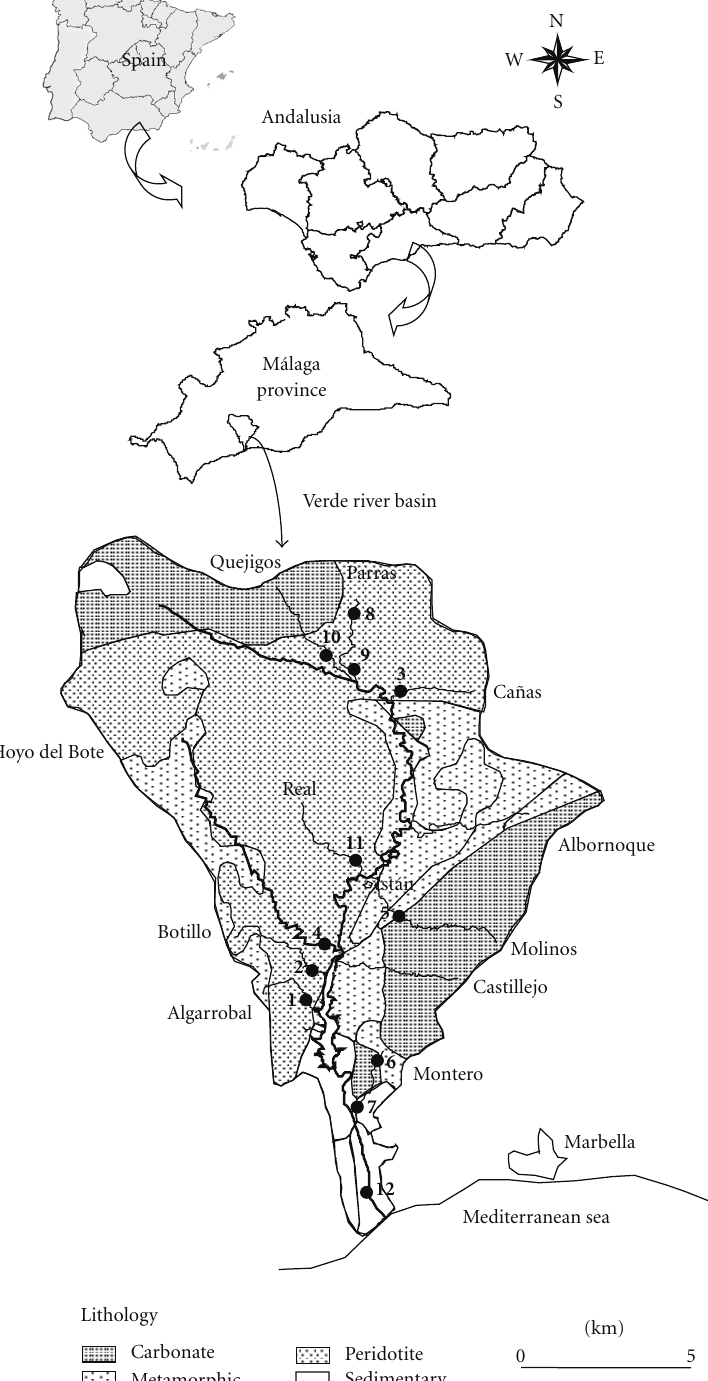
Figure 1: Location of the study area, sampling points, and lithological scheme of the River Verde